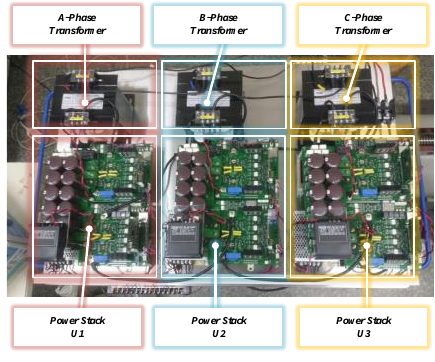
Figure 24. Experimental setup 2 of the 13-level cascaded NPC/H-bridge system